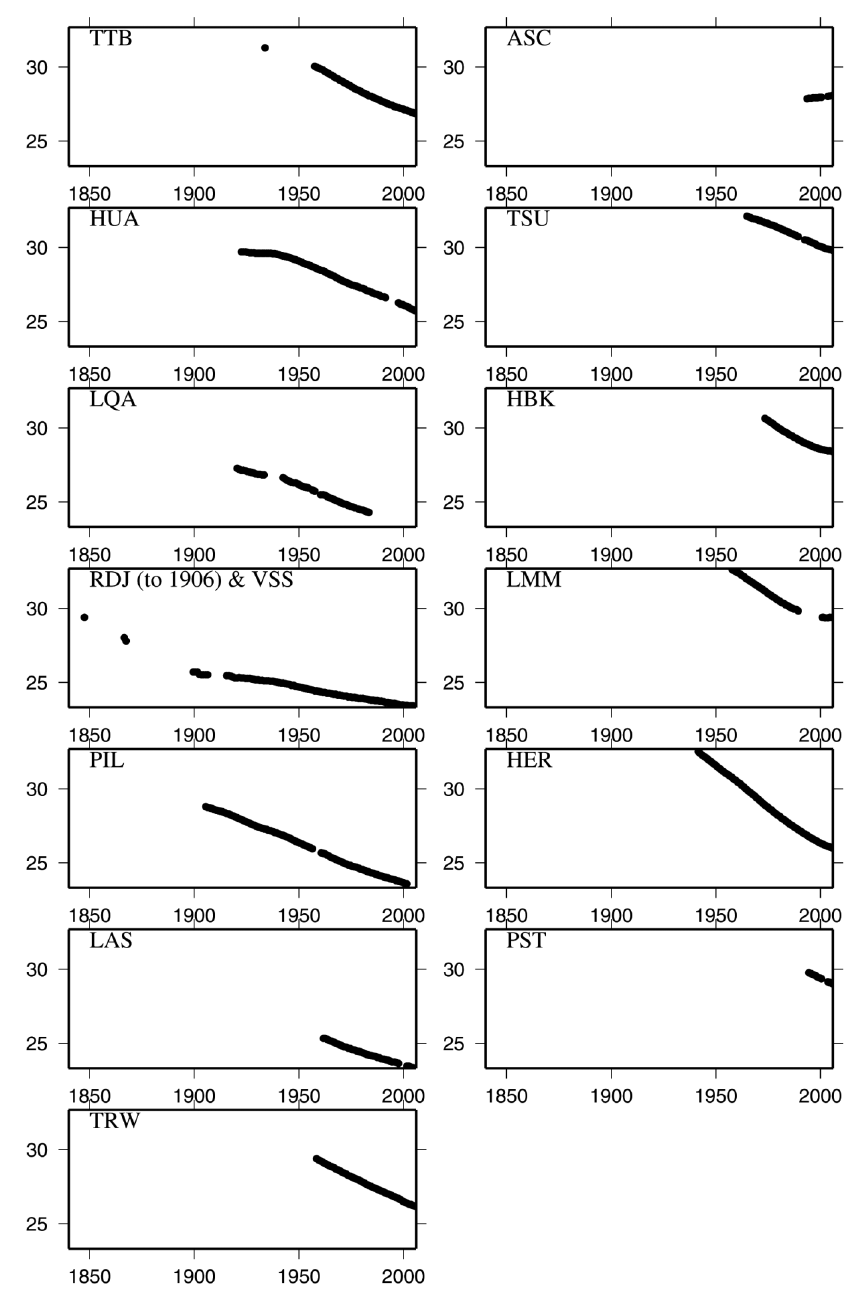
Fig. 5. Annual means of total intensity ( µ T) at selected long-running observatories in region of SAA. Locations of observatories are shown in fig.